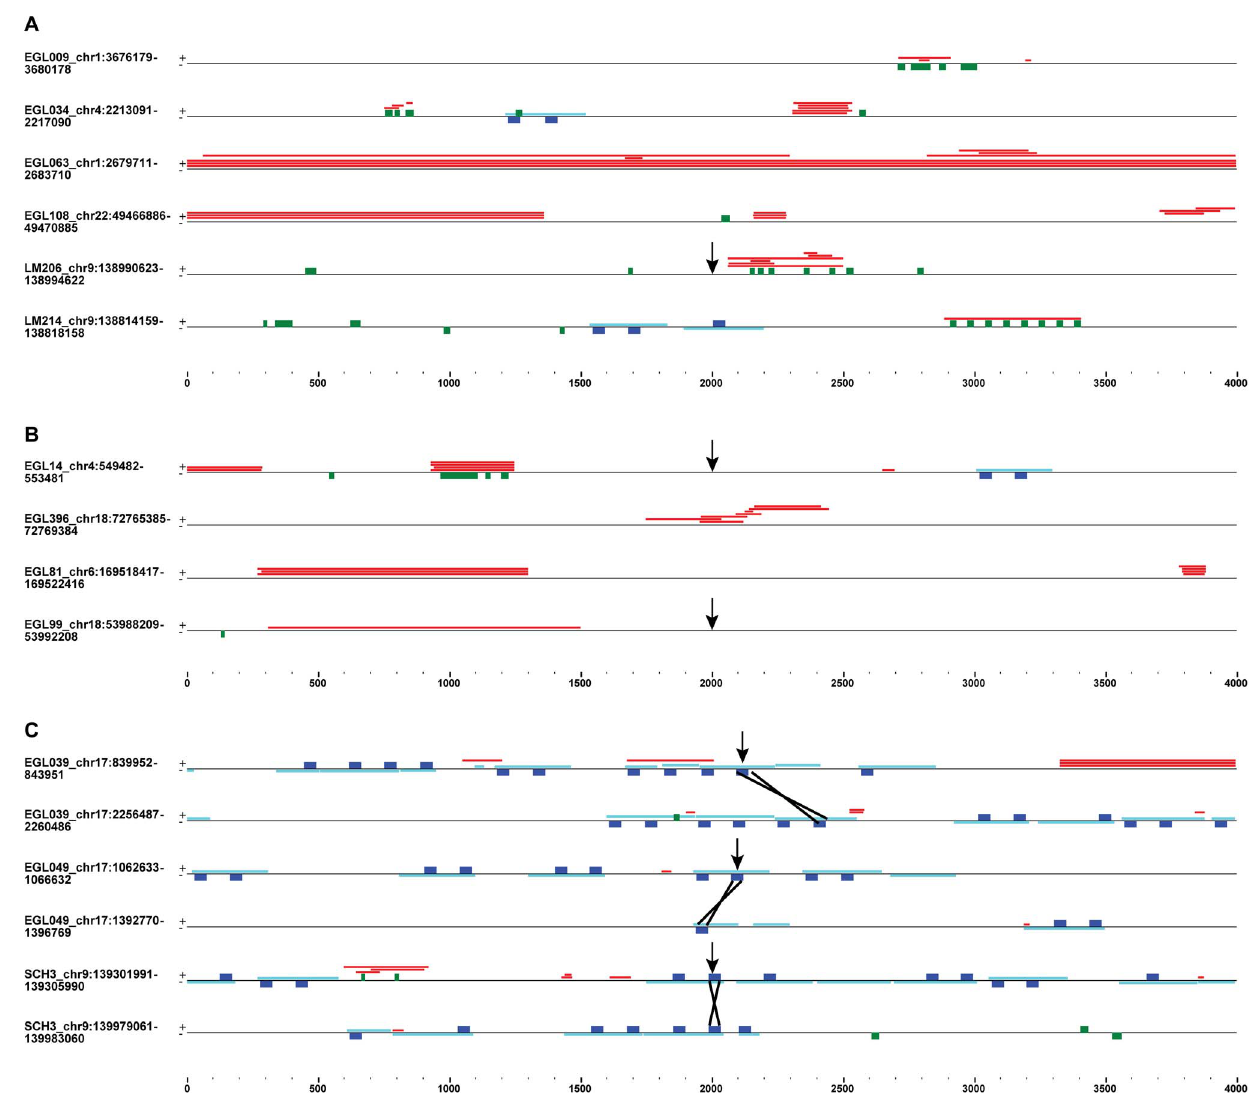
Figure 2. Repeats in 4-kb CNV breakpoint regions. The location of tandem repeats (red), G-quadruplexes (green), Alu s (light blue) and 50-bp motif (dark blue) sequences are shown for a subset of terminal deletion ( A ), inverted duplication adjacent to terminal deletion ( B ) and interstitial deletion ( C ) breakpoint regions. Repeats on the positive ( + ) and negative ( 2 ) strands are shown on the top and bottom of the black line, respectively. Arrows point to sequenced breakpoint junctions. The breakpoint region from EGL108 underlies terminal deletions and one interstitial duplication. Black Xs show Alu - Alu recombination sites for sequenced junctions ( C ).